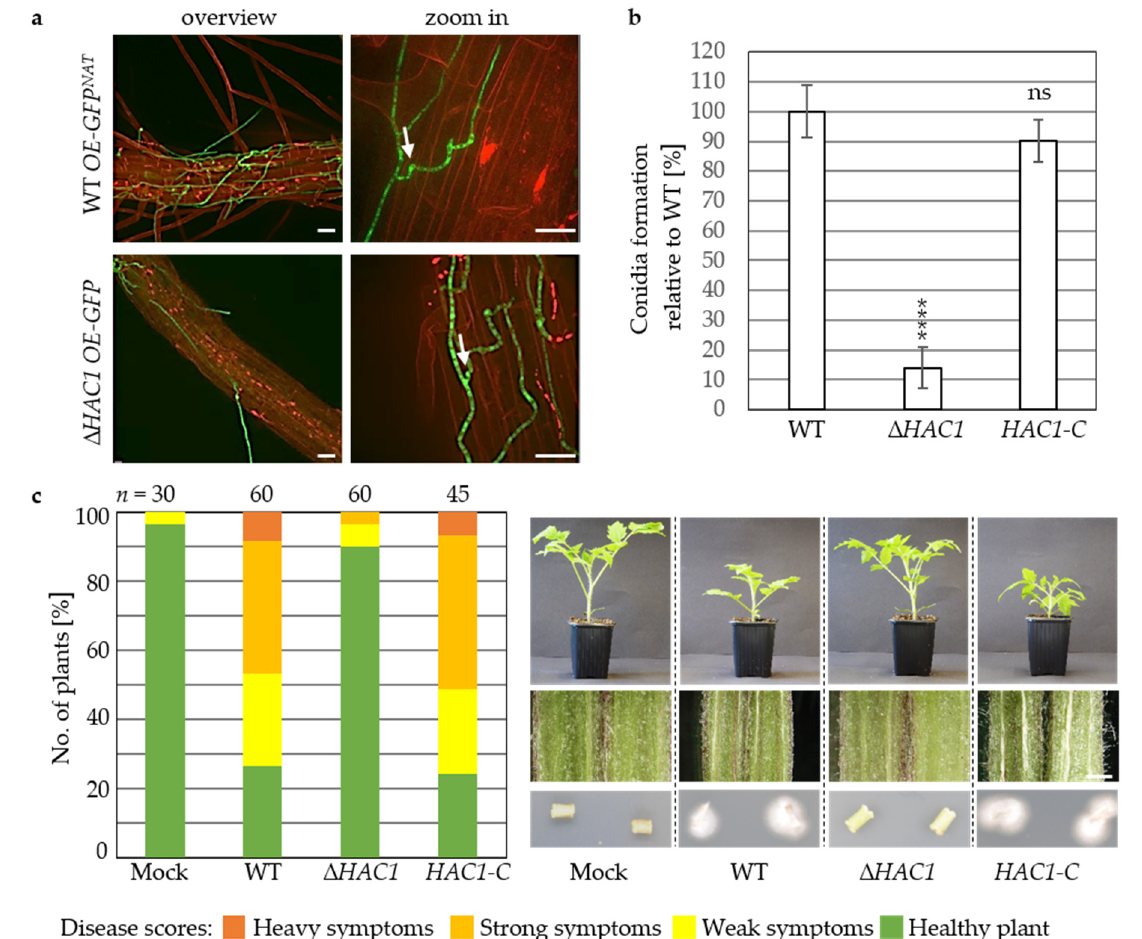
Figure 3. Verticillium dahliae HAC1 is required for root colonization, conidiation, and induction of disease symptoms in tomato. V. dahliae wildtype (WT), HAC1 deletion ( ∆ HAC1 ), and complementation ( HAC1-C ) strains, as well as wildtype and HAC1 deletion strain constitutively expressing ectopic GFP (WT OE-GFP NAT , Δ HAC1 OE-GFP ) were compared. ( a ) V. dahliae colonization of Arabidopsis thaliana roots. Fluorescence confocal microscopy was performed 7 d post inoculation of roots with the same numbers of spores from wildtype WT OE-GFP NAT or ∆ HAC1 OE-GFP with four plants per strain in two independent experiments. ∆ HAC1 OE-GFP propagation on the root surface is reduced, but penetration of the root (white arrows) with subsequent colonization of the root cortex was observed (Scale bar = 20 µm). ( b ) Quantification of conidiation in ∆ HAC1 . ∆ HAC1 shows reduced conidiation 5 d post inoculation of liquid simulated xylem medium in comparison to wildtype and HAC1-C . Mean values of four independent experiments relative to wildtype with standard deviations are shown. (Significant differences to wildtype: **** p = 0, ns = non-significant, n ≥ 4). ( c ) Pathogenicity test of Δ HAC1 mutant compared to wildtype towards Solanum lycopersicum . Representative tomato plants (right, top) and hypocotyl dissections (right, middle) 21 d after root dipping into distilled water control (Mock) or same numbers of spores obtained from different strains are shown (Scale bar = 1 mm). Relative amount of plants with certain disease scores from two independent experiments are displayed in the stack diagram ( n = total number of evaluated plants). Δ HAC1 -treated plants display disease symptoms in only few plants, mock-like hypocotyl coloration and no fungal outgrowth from surface sterilized stem sections after 7 d (bottom).